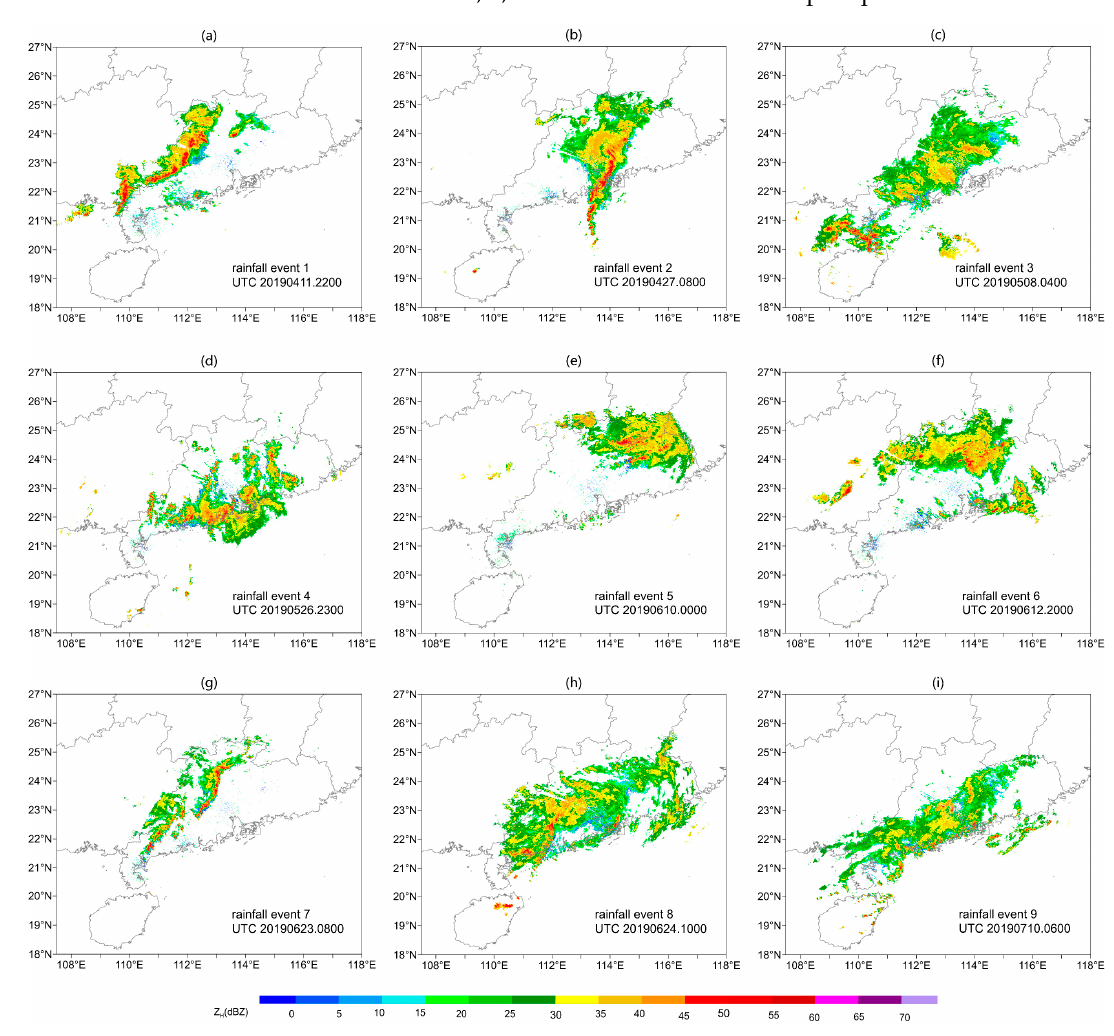
Figure 2. ( a – i ) Typical mosaic echoes of the rainfall event 1–9. The corresponding rainfall events and time are indicated at the bottom right of each image.